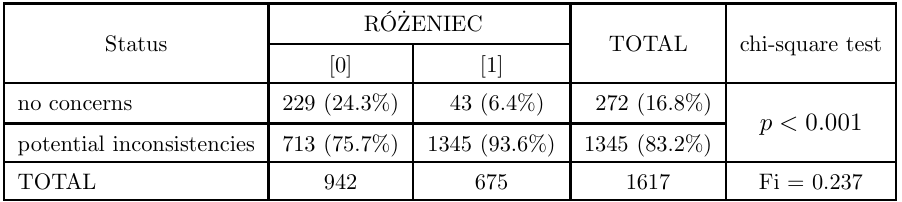
Table 4. Relationship between the occurrence of the “różeniec” ingredient and its